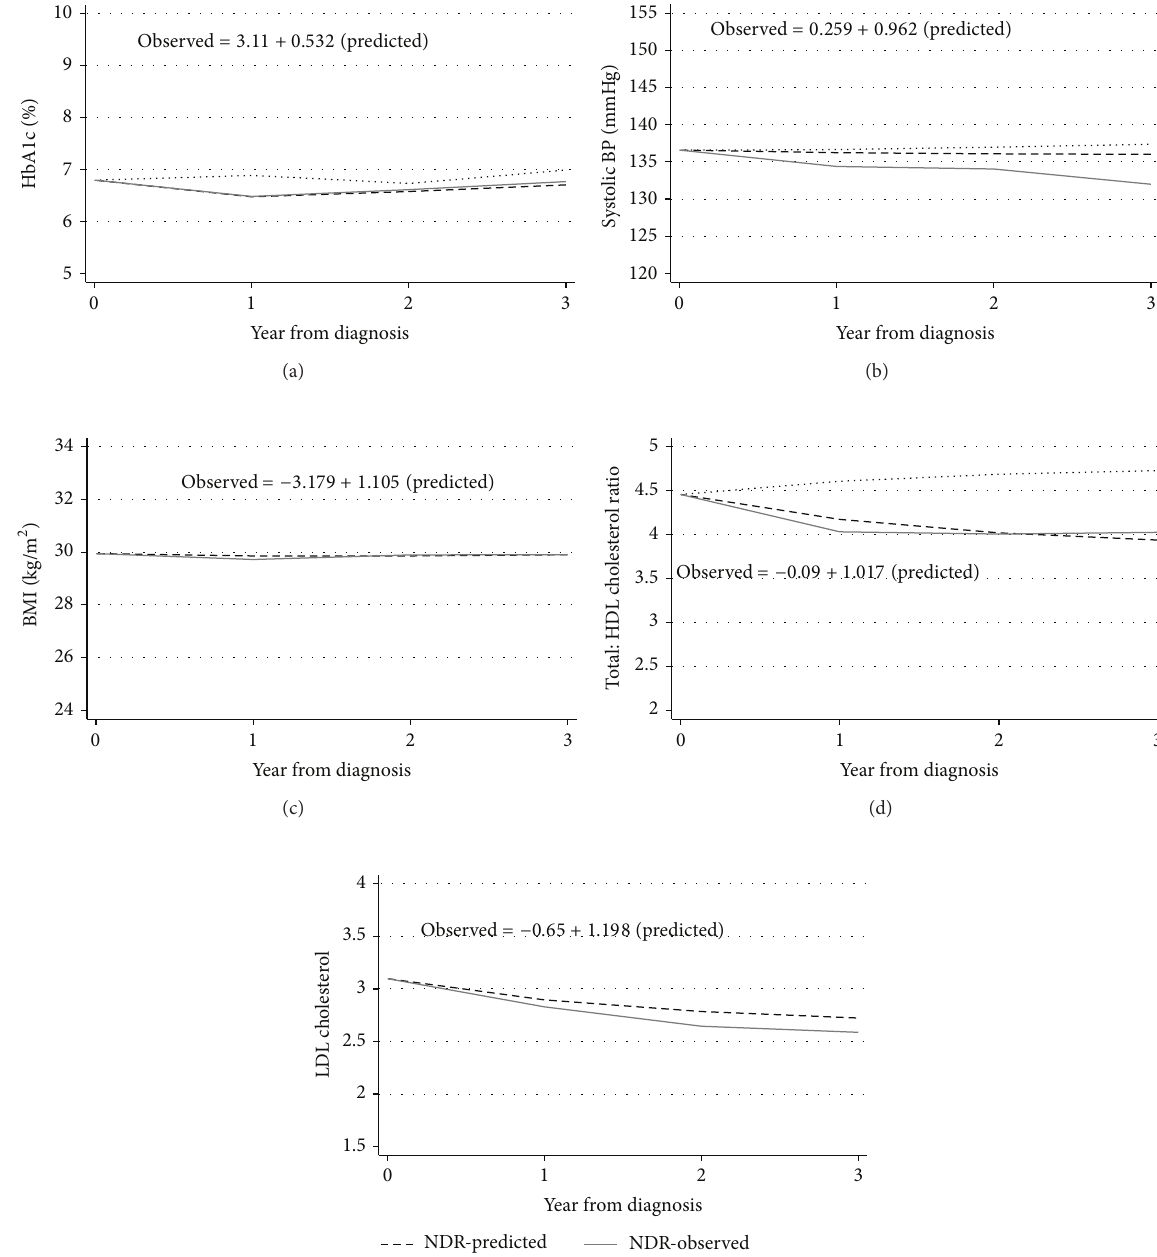
Figure 1: Predicted and observed time paths of risk factors. Time paths of (a) HbA 1 cholesterol for nonsmoker males in the validation sample. Equations show the regression of NDR-observed values on NDR-predicted values (BMI and LDL were not estimated in UKPDS outcome